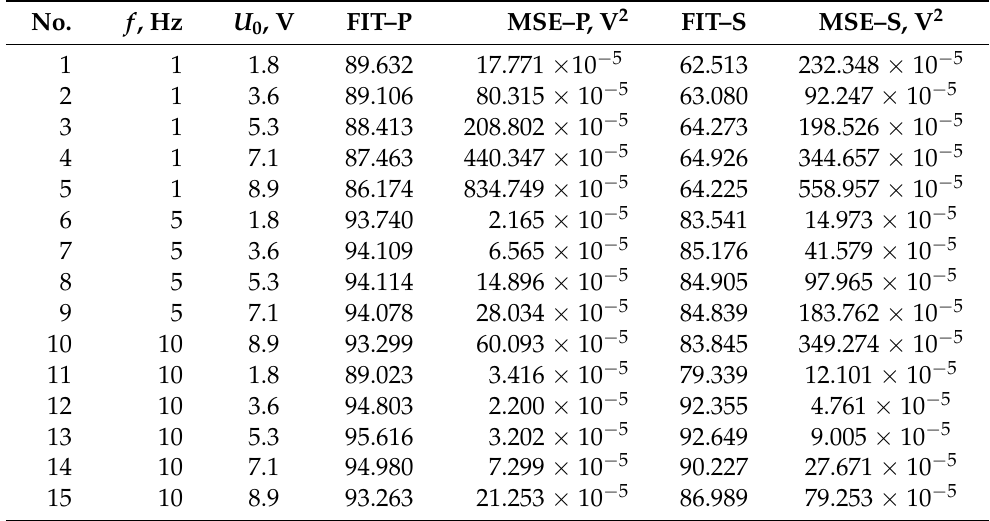
Table 1. Calculated quality metrics, FIT(MSE)–P: prediction mode metrics, FIT(MSE)–S: simulation mode